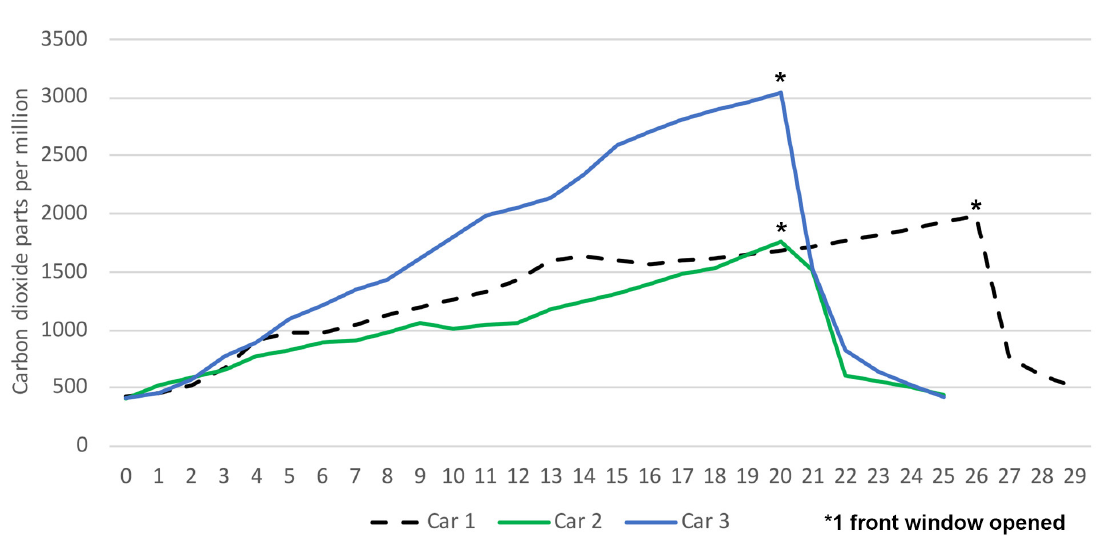
Figure 2. Highway driving on recirculation mode. Carbon dioxide levels in 3 cars when driven on the highway with the fan on and the ventilation system set on recirculation mode. *, 1 front window partially or fully opened. Carbon dioxide readings above 800 parts per million were considered an indicator of suboptimal